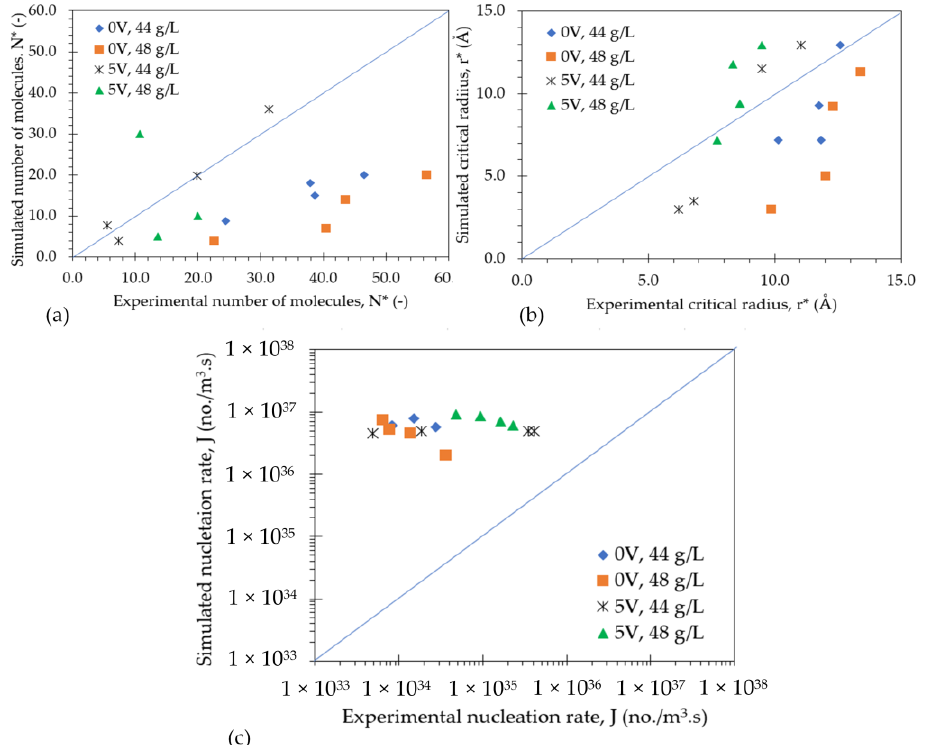
Figure 11. Comparison between experimental and simulated values for ( a ) the critical number of molecules, N*, ( b ) critical radius, r*, and ( c ) nucleation rate,